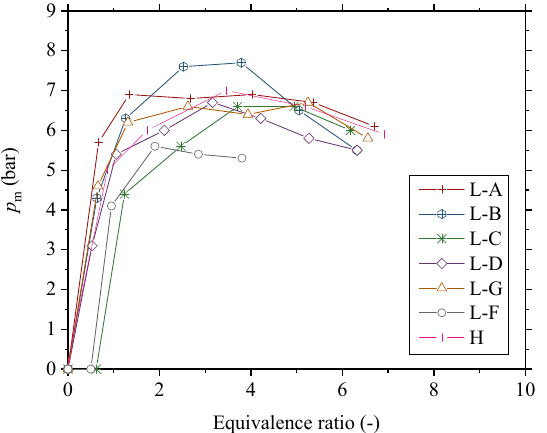
Figure 4. Explosion pressure ( p m ) versus the equivalence